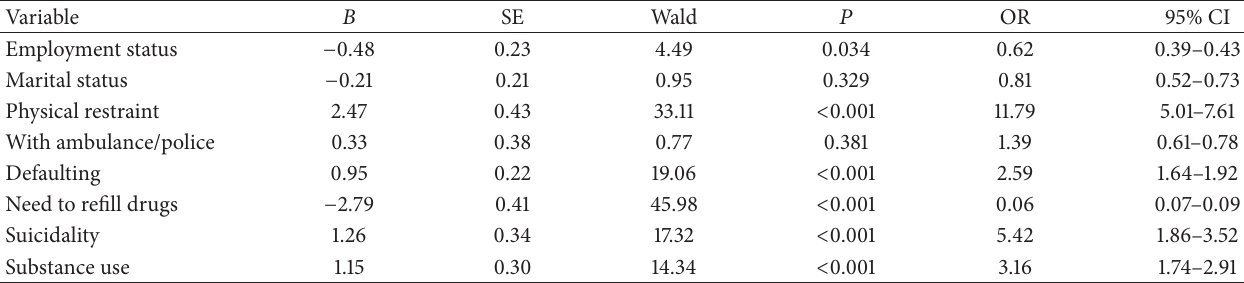
Table 5: Regression analysis of factors associated with urgency of